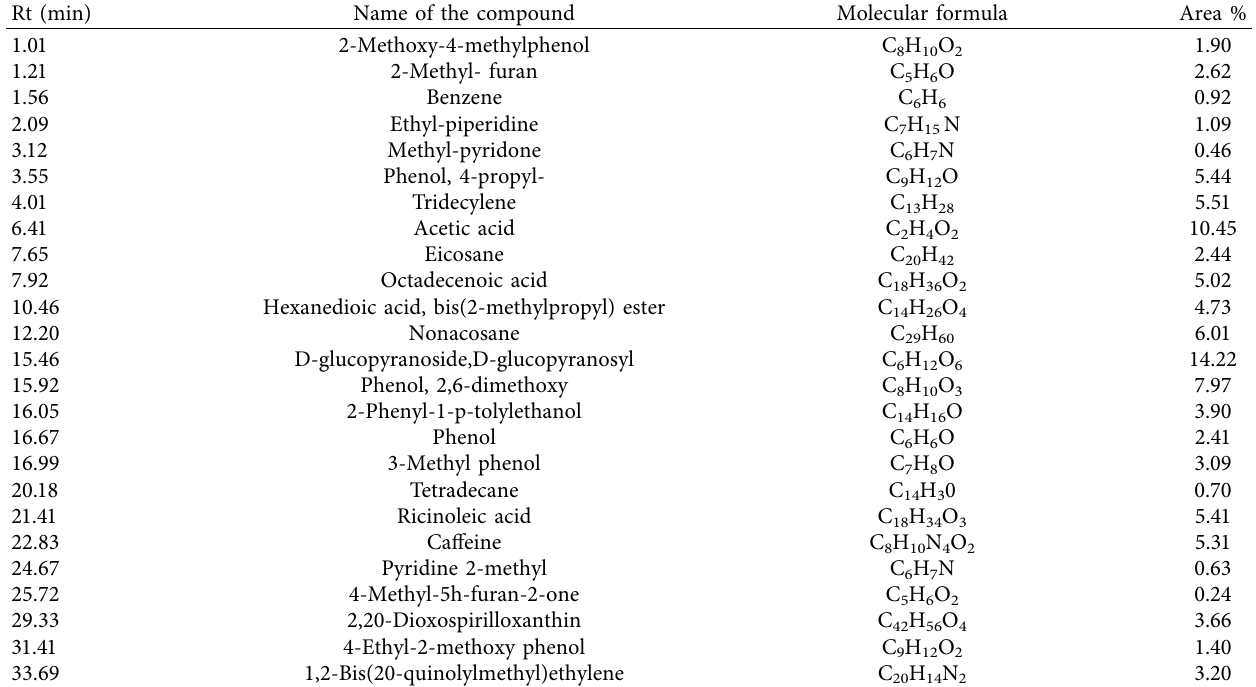
Table 6: GC-MS analysis of tea waste pyrolysis